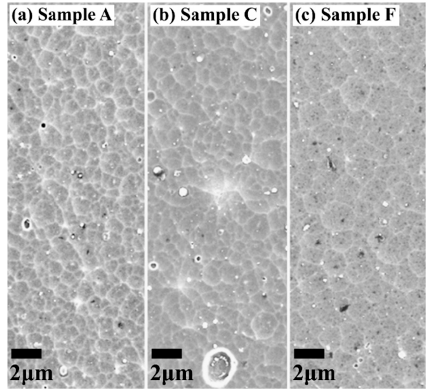
Figure 10. SEM micrographs showing the surface morphology of ( a ) coating A, ( b ) coating C, and ( c ) coating F.